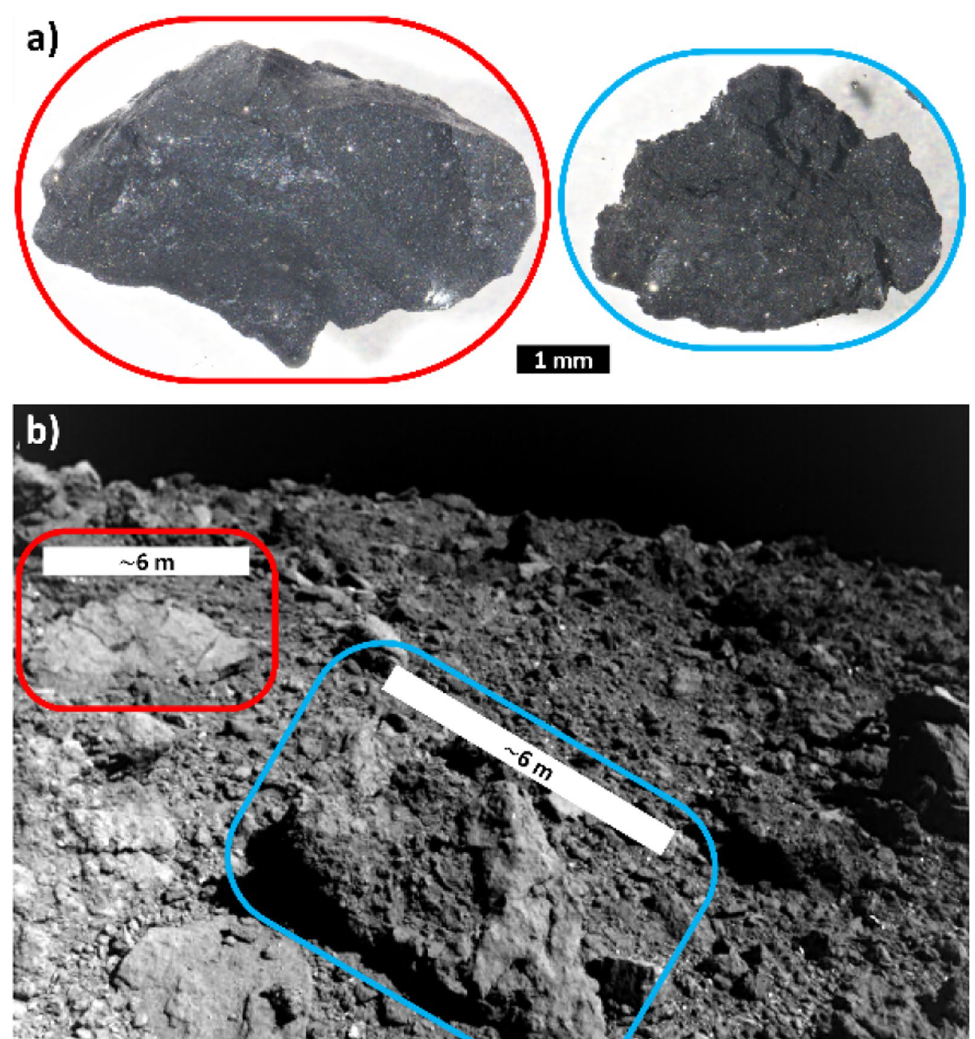
Fig. 4 a Two fragments of returned samples showing smooth (red) and rough (blue) surface textures and b smooth (red) and rough (blue) boulders imaged by MasCam during its descent. The scale bars are only approximately applicable at the indicated location. Note the different scale in a) and b). The shown fragments in a) are labeled C0005 (left) and C0008 (right) and were retrieved from the Hayabusa2, Ryugu Sample Curatorial Data Set (Astromaterials Science Research Group (ASRG)